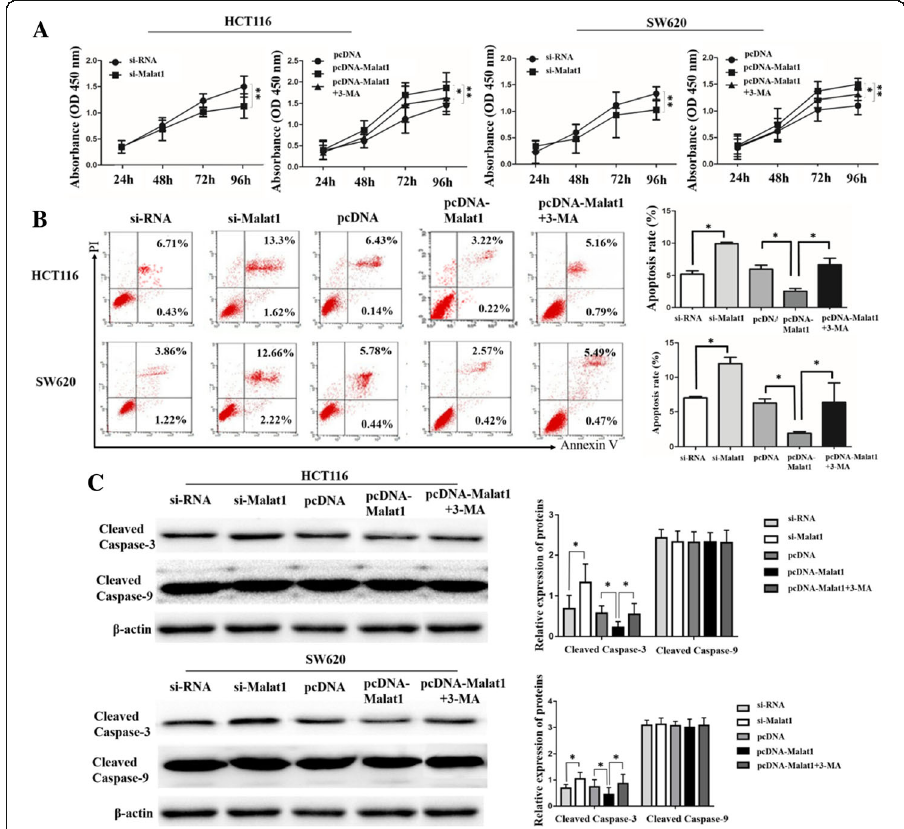
Fig. 3 Malat1 increased cell proliferation and deduced apoptosis by activating autophagy. CCK-8 proliferation assay ( a ), flow cytometry (FCM) assay ( b ) and Western blot assay ( c ) show the effects of Malat1 downregulation or Malat1 upregulation on HCT116 and SW620 cell proliferation, apoptosis and apoptosis protein (cleaved caspase-3 and cleaved caspase-9) expression levels, and autophagy inhibition by 3-MA relieves induced cell proliferation and reduced cell apoptosis and cleaved caspase-3 expression level by Malat1 upregulation. The columns show the mean for three separate experiments. * p < 0.05, ** p <